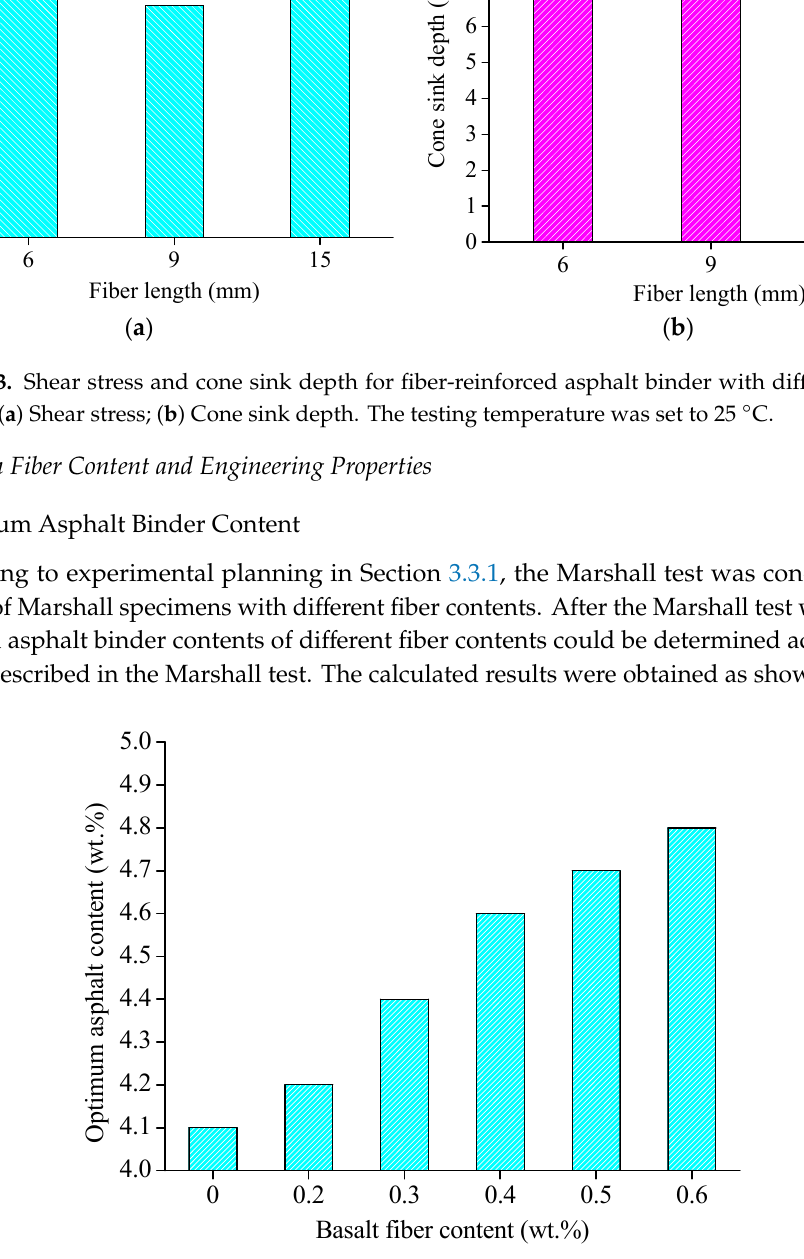
Figure 14. Optimum asphalt binder contents for different fiber contents.